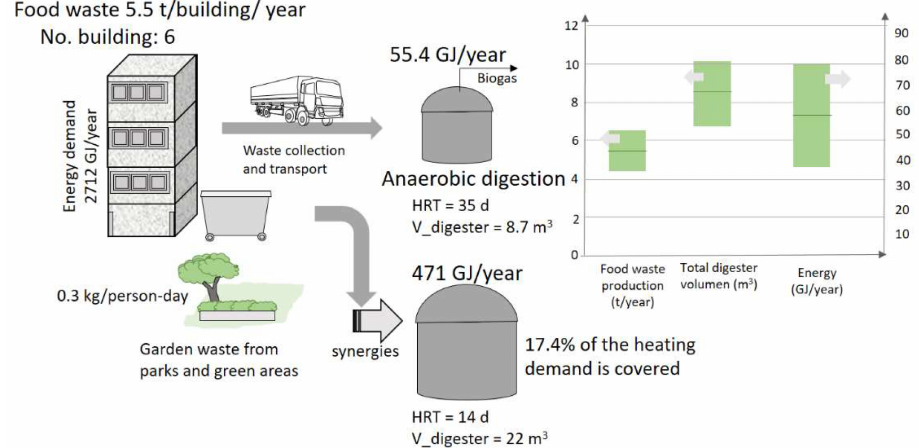
Figure 3. Results obtained from Scenario 1, considering residential housing in highly populated areas. Reactors considered in this scenario were a CSTR type operating at low solid